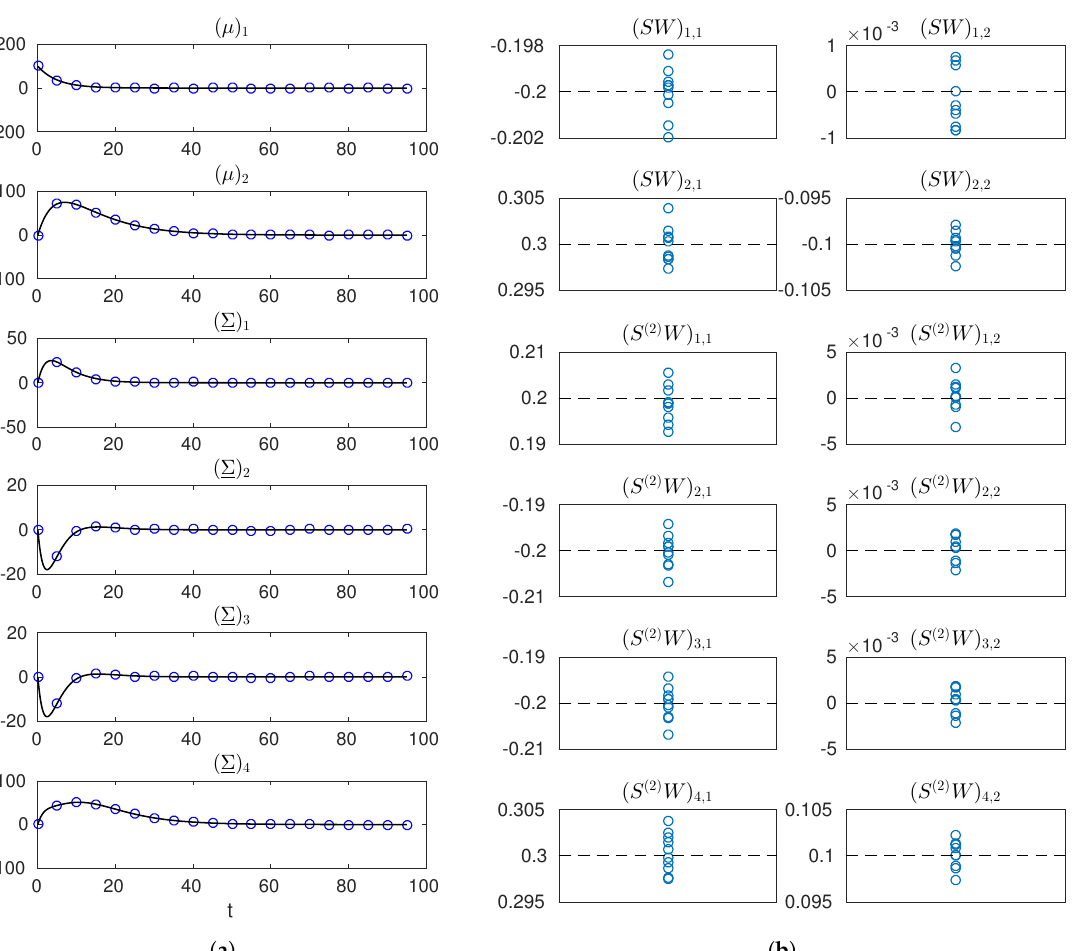
Figure 3. Simulated measurements and estimates of S ∗ W ∗ and ( S ∗ ) ( 2 ) W ∗ for the network reconstruction example. ( a ) true trajectories of the entries of µ and Σ (solid black line) and one simulated dataset (blue markers); ( b ) estimates of the entries of S ∗ W ∗ and ( S ∗ ) ( 2 ) W ∗ (blue markers) obtained from 10 different datasets (dashed black lines indicate true values). Notation ( · ) r , c is used in labels to denote the row- r , column- c entry of a